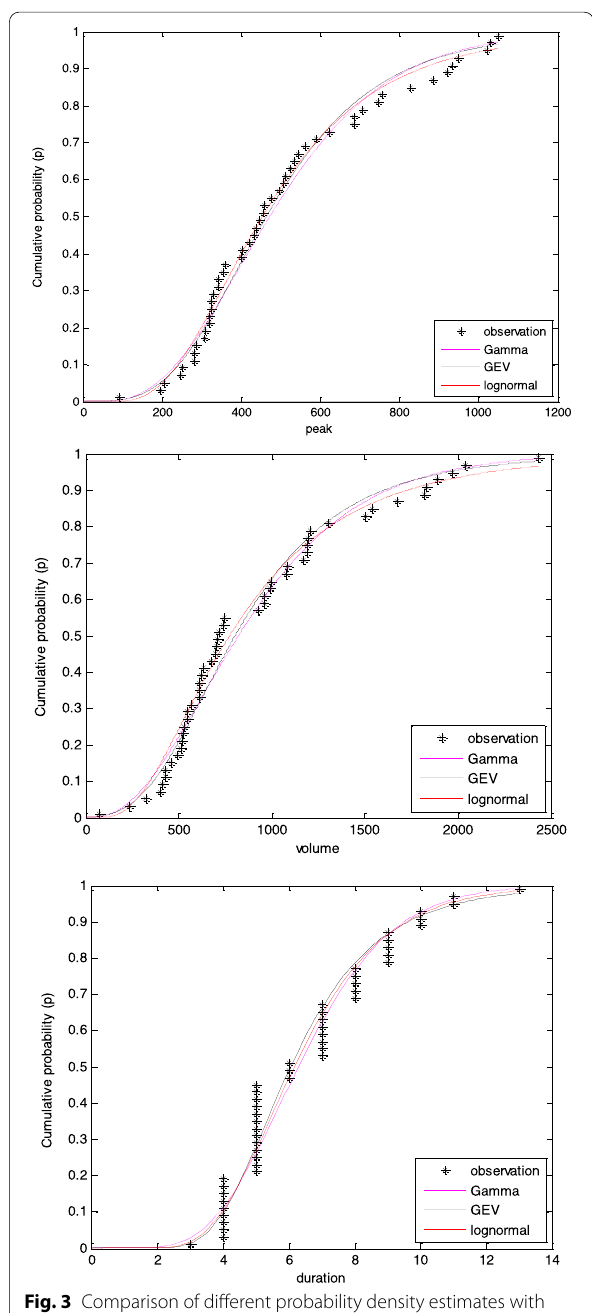
Fig. 3 Comparison of different probability density estimates with observed